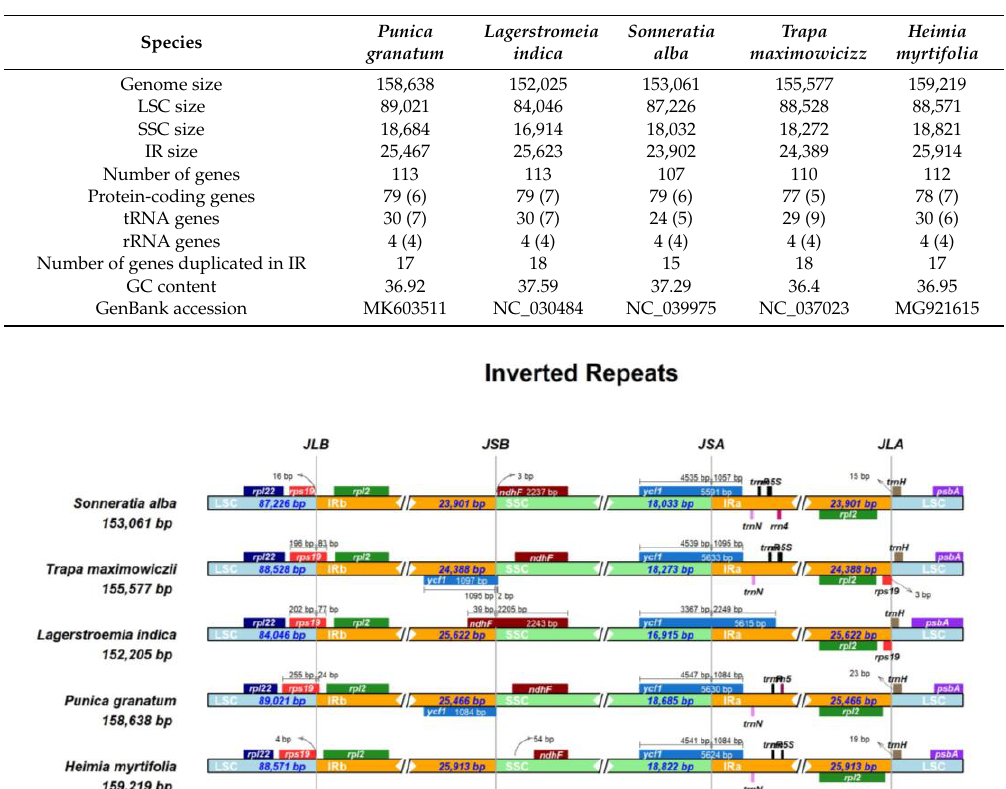
Table 4. Summary of the complete chloroplast genome characteristics of five species in Lythraceae.